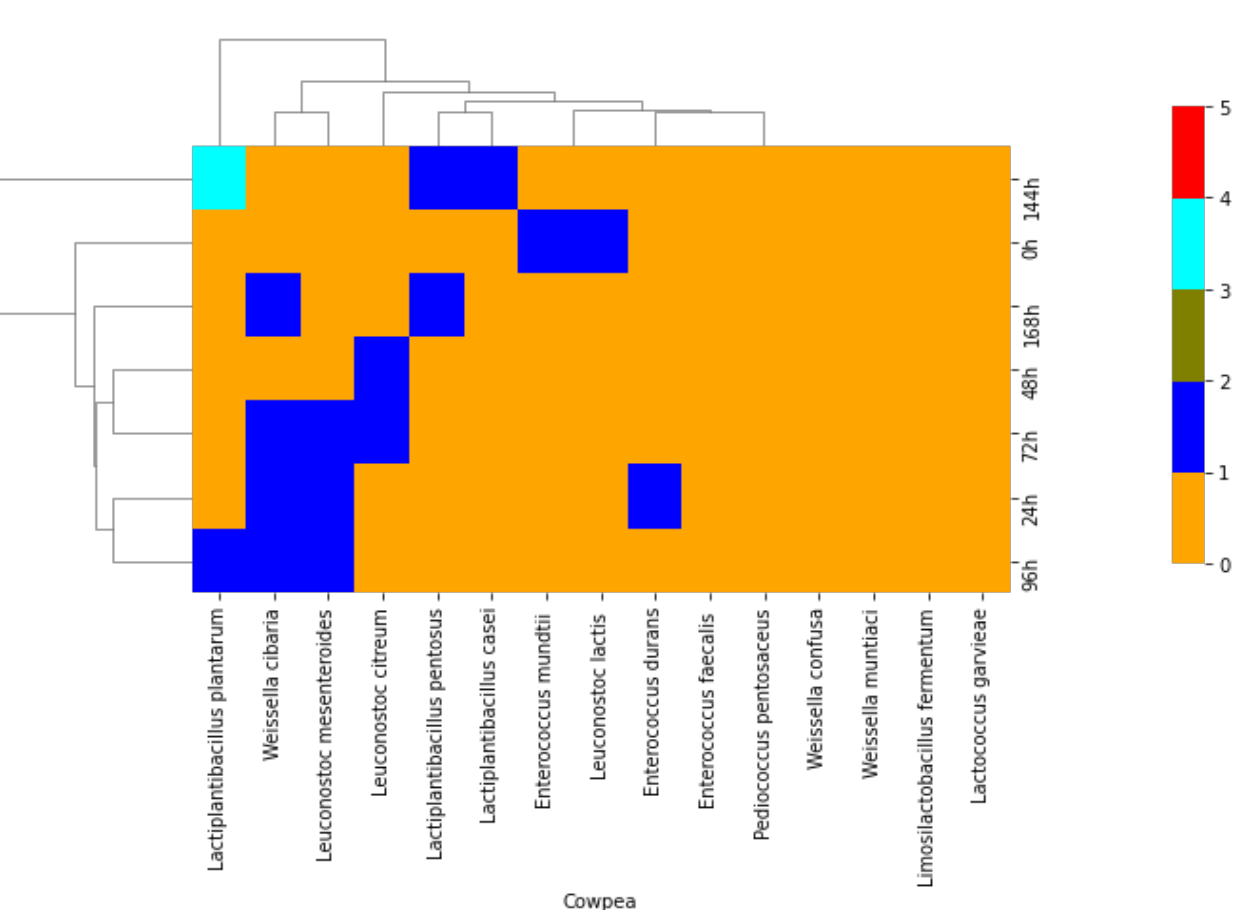
Figure 4 . Hierarchical clustering of lactic acid bacteria at the species from fermented cowpea leaves at different fermentation times . Legend: Hierarchical clustergram generated using several bacterial species from cowpeas at different times. The heatmap (Euclidean matric) shows the relationship between selected bacteria species and varied times. The colored scale bar indicates the significant quantified strength of the various times. The red color in the heatmap indicates the highest and orange indicates the lowest significance at p ≤ 0.05 for the assayed treatments.